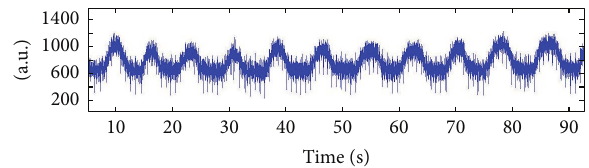
Figure 3: A raw SCG signal was acquired from the measurement